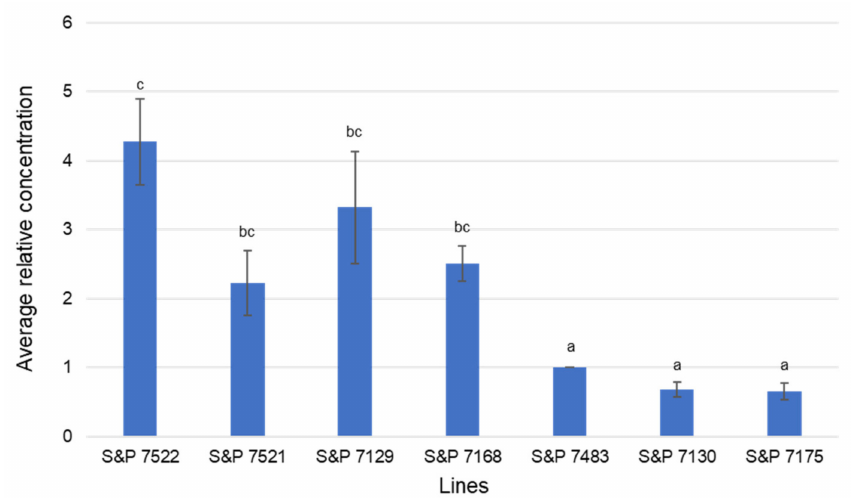
Figure 8. The gene expression level of the aldo-keto reductase (ARK) gene in the seven onion lines using the SNP-3 primer by the qPCR analysis. Four resistant lines (S&P 7522, S&P 7521, S&P 7129, and S&P 7168) and three susceptible lines (S&P 7483, S&P 7130, and S&P 7175) were analyzed. The qPCR analysis was performed in six replicates, and the standard errors are indicated as bars. Means with the same letter on the bar were not significantly different according to Duncan’s multiple comparison